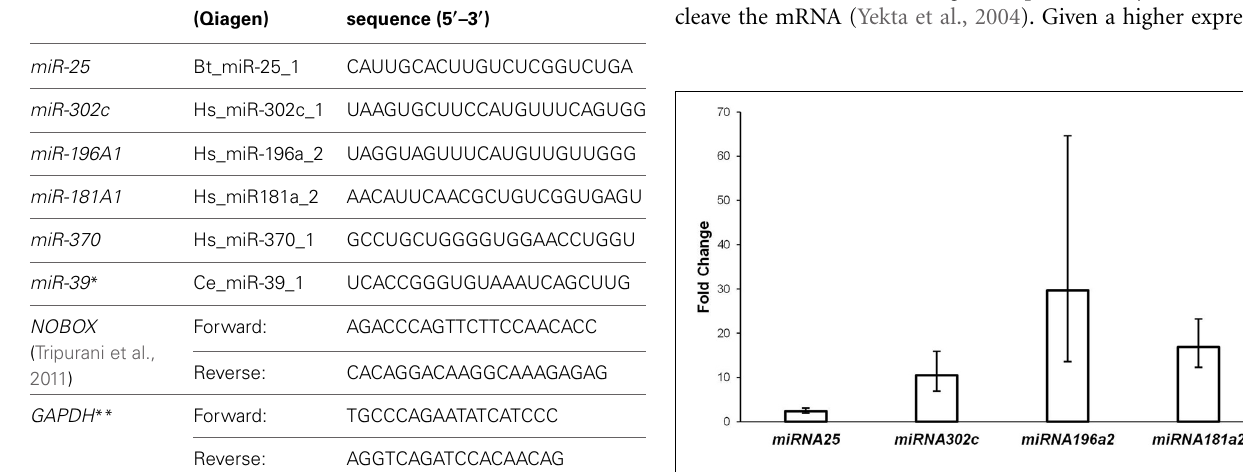
FIGURE 2 | Relative fold change difference in gene expression of degenerate to blastocyst